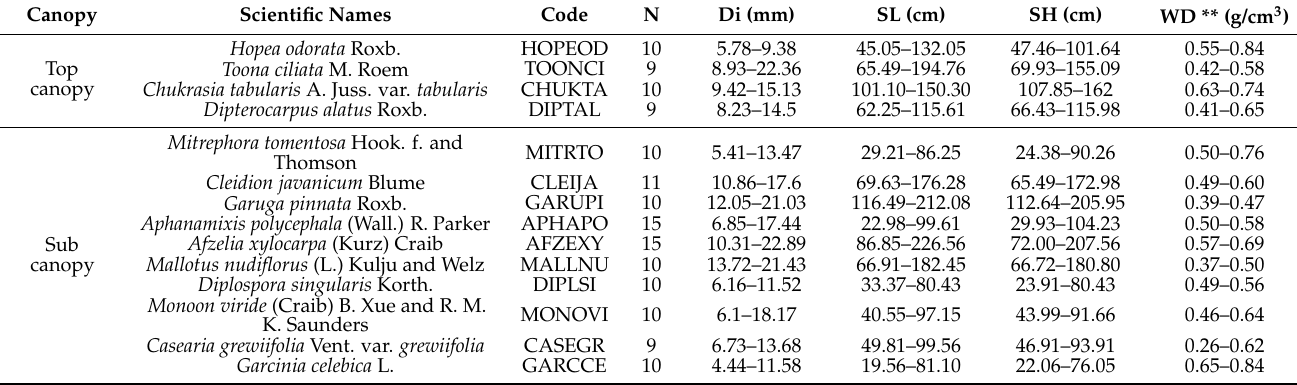
Table 1. Sample size and range of seedling measurements from the current study